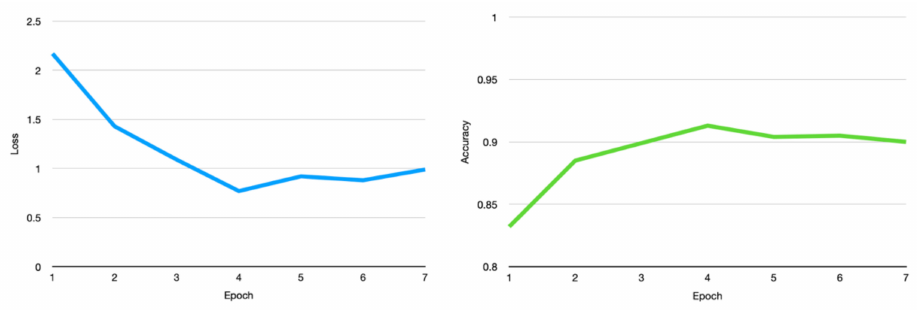
Figure 7. Loss and Accuracy fluctuation in different Epoch.